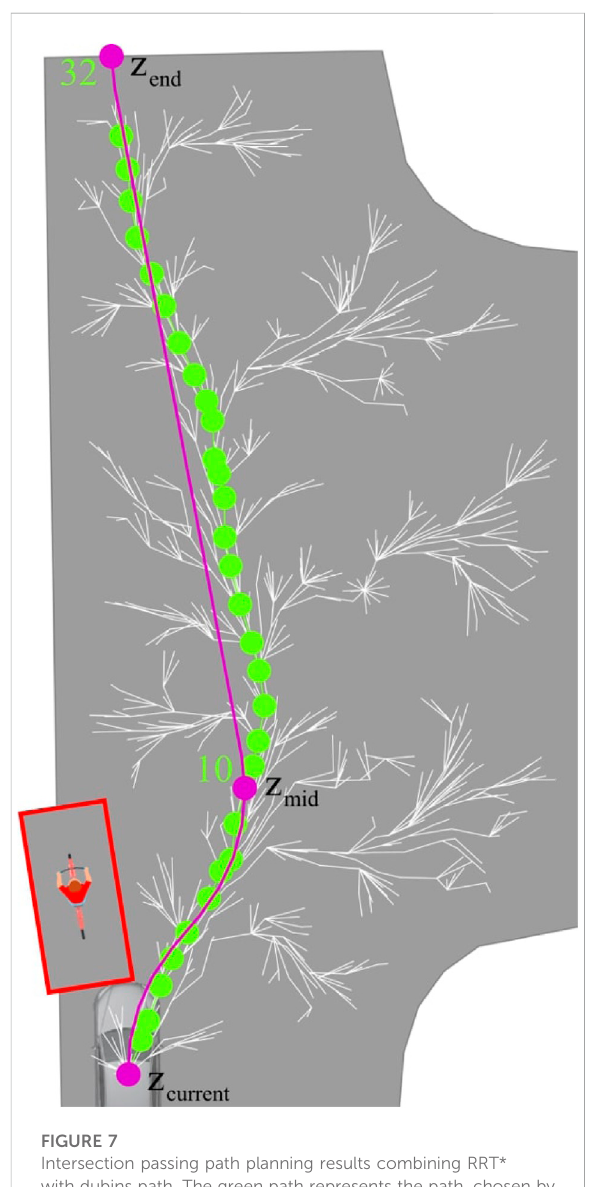
FIGURE 7 Intersection passing path planning results combining RRT* with dubins path. The green path represents the path, chosen by the RRT* algorithm. The purple curve then gives the optimsed dubins path, whilst the white edges show the complete RRT*